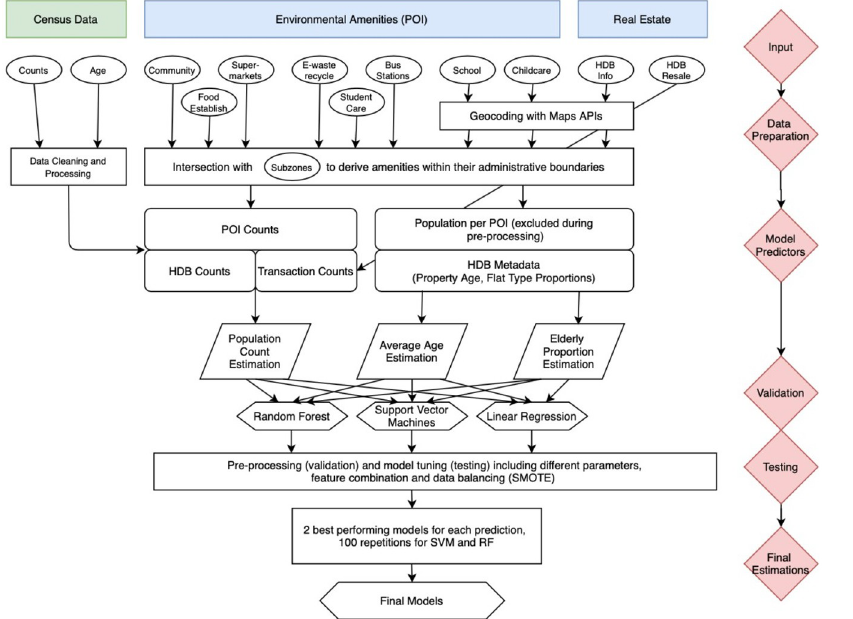
Fig 1. Detailed flowchart of the method and the employed